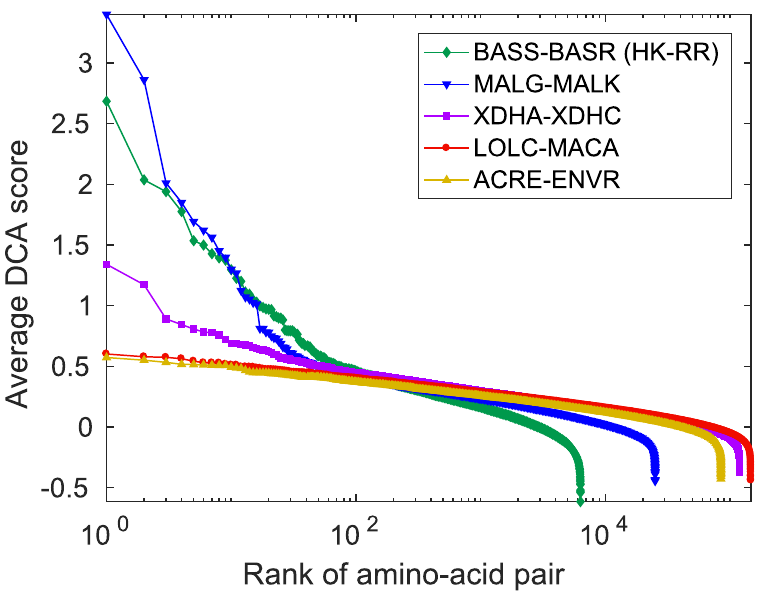
Fig 7. Outliers in DCA score provide evidence of protein-protein interactions. DCA scores (APC-corrected Frobenius norms [17, 47]) were evaluated for each pair of amino-acid sites at the final IPA iteration. Their averages over 500 IPA replicates that differ in their initial random pairings of sequences are shown ranked by decreasing value. Datasets correspond to the same protein family pairs as in Fig 6, and the IPA was run with N increment = 50. Outliers in DCA score appear for all three pairs of protein families with known direct physical interactions (BASS-BASR, MALG-MALK, XDHA-XDHC), but not for the other ones (LOLC-MACA, ACRE-ENVR).